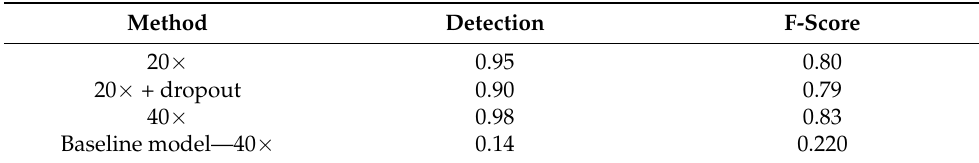
Table 8. Nuclei segmentation